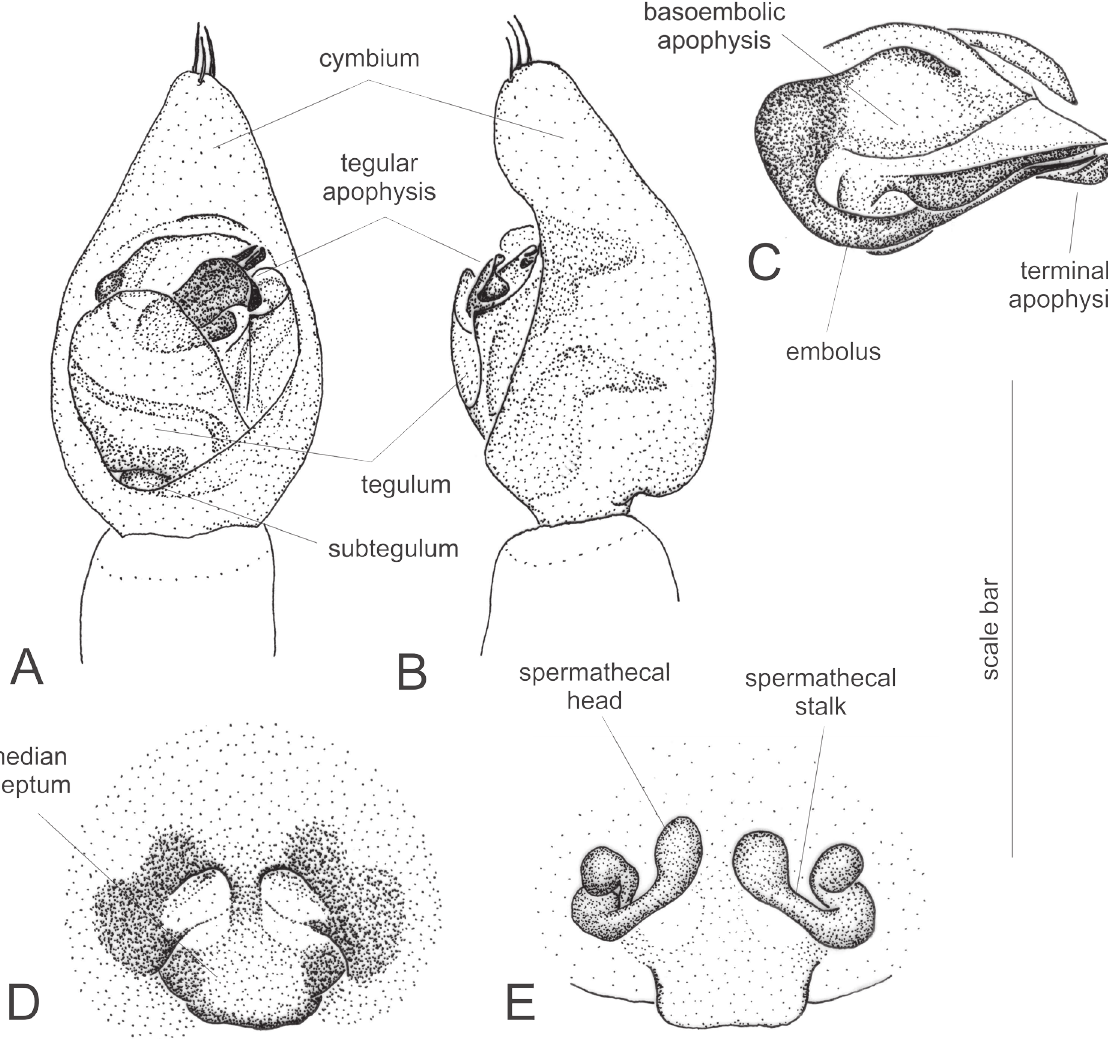
Fig. 7. Tetralycosa arabanae (Framenau, Gotch & Austin, 2006), ♂, paratype (SAM NN13887) and ♀ (WAM T47297, T47296). A–B . Left male pedipalp, ventral and retrolateral view. C . Left male pedipalp, palea section of bulbus, ventral view. D . Female epigyne, ventral view (WAM T47297). E . Female epigyne, dorsal view (WAM T47296). Scale bar: A–B = 1.02 mm; C = 0.32 mm; D–E =